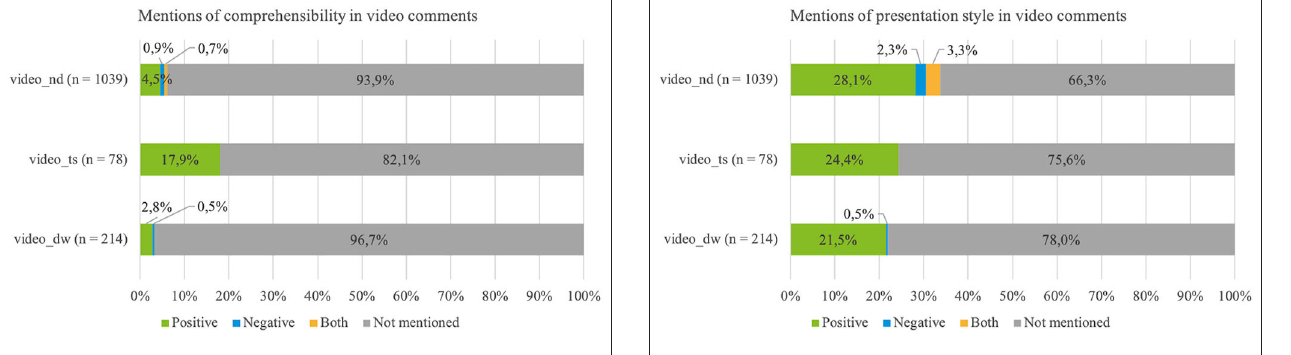
“Great video, great content, explanations etc.